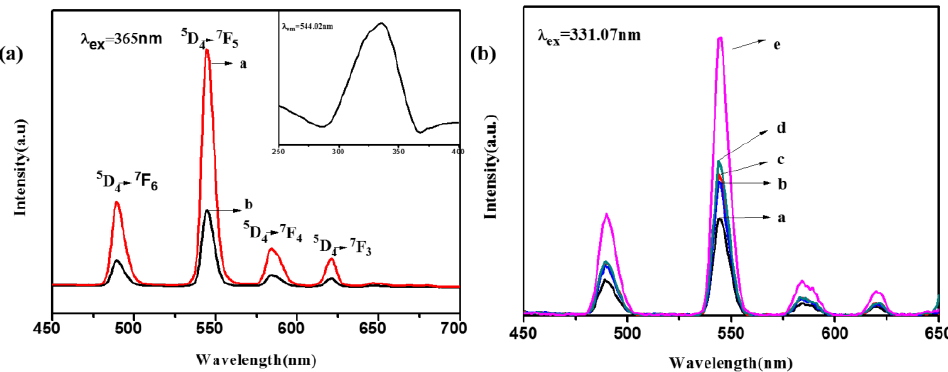
Figure 3. Fluorescence emission spectra of the polymer solution ( a ) and the microspectrophotometer emission spectra of different complexes (a: b 3+ /PET–TEG/Phen; b: SiO 2 @Tb 3+ (PET–TEG) 3 Phen); fluorescence excitation spectra at different concentrations ( b ) (polymer solution concentrations of a– e: 0.01, 0.002, 0.004, 0.008, and 0.006 mol/L, respectively).